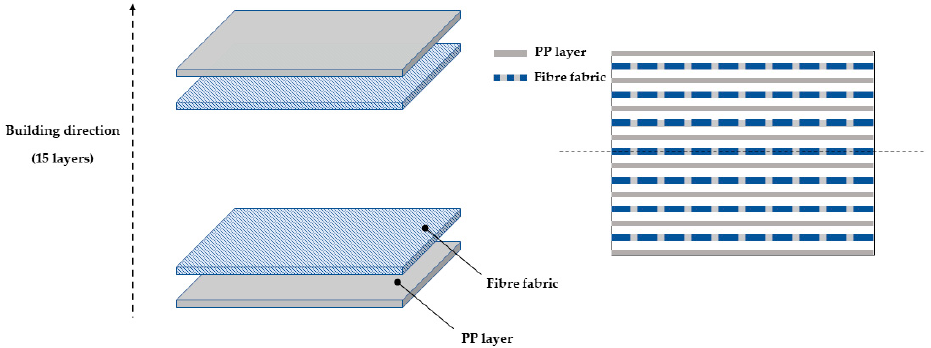
Figure 1. Exemplificative sketch of the laminates build-up sequence.